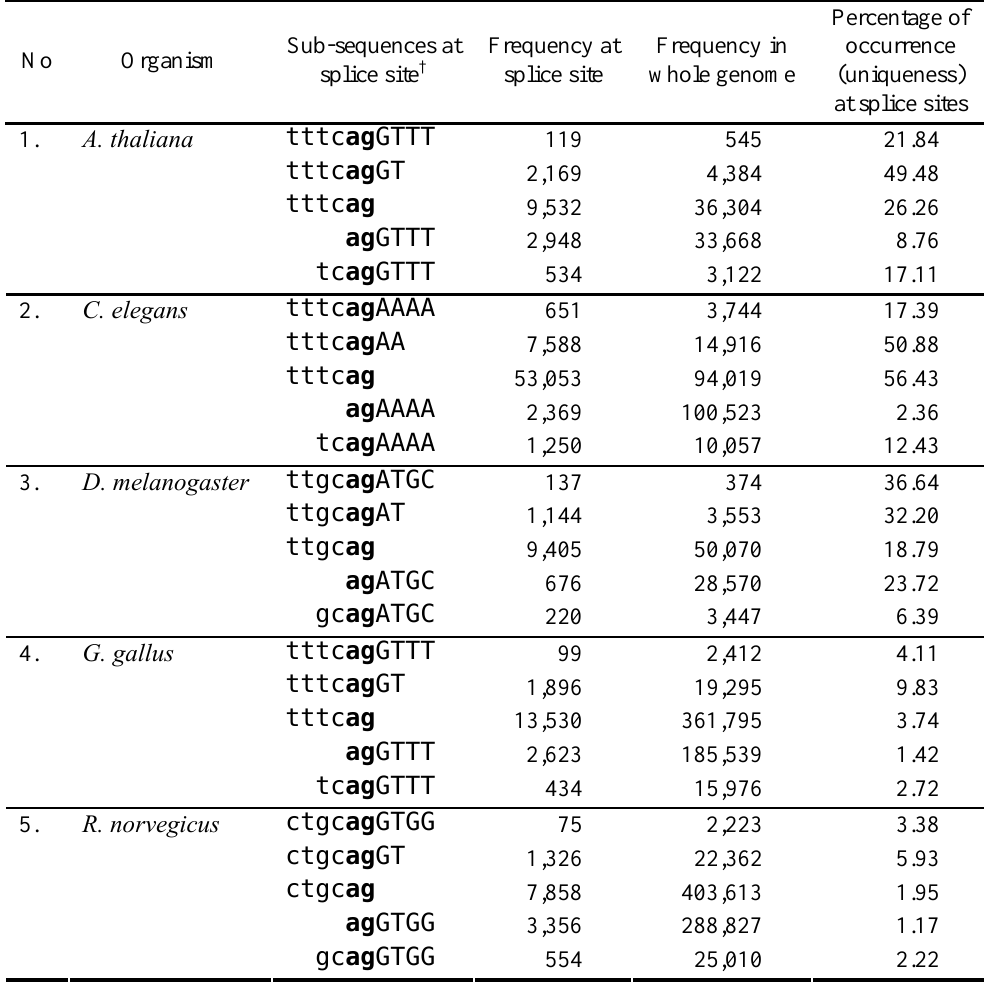
Table 5b. Percentage of occurrence (uniqueness) of different sub-sequences (with highest frequency) of size ten at the acceptor splice site region and the whole genome of the